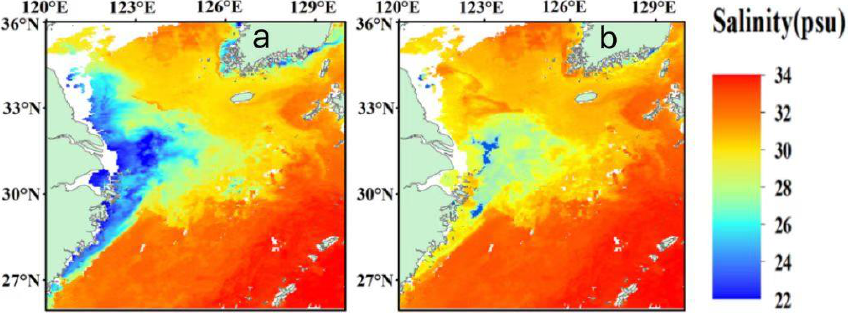
Figure 10. The inversion results in August 2020 based on complex models ( a ) and with machine learning based model only ( b ).